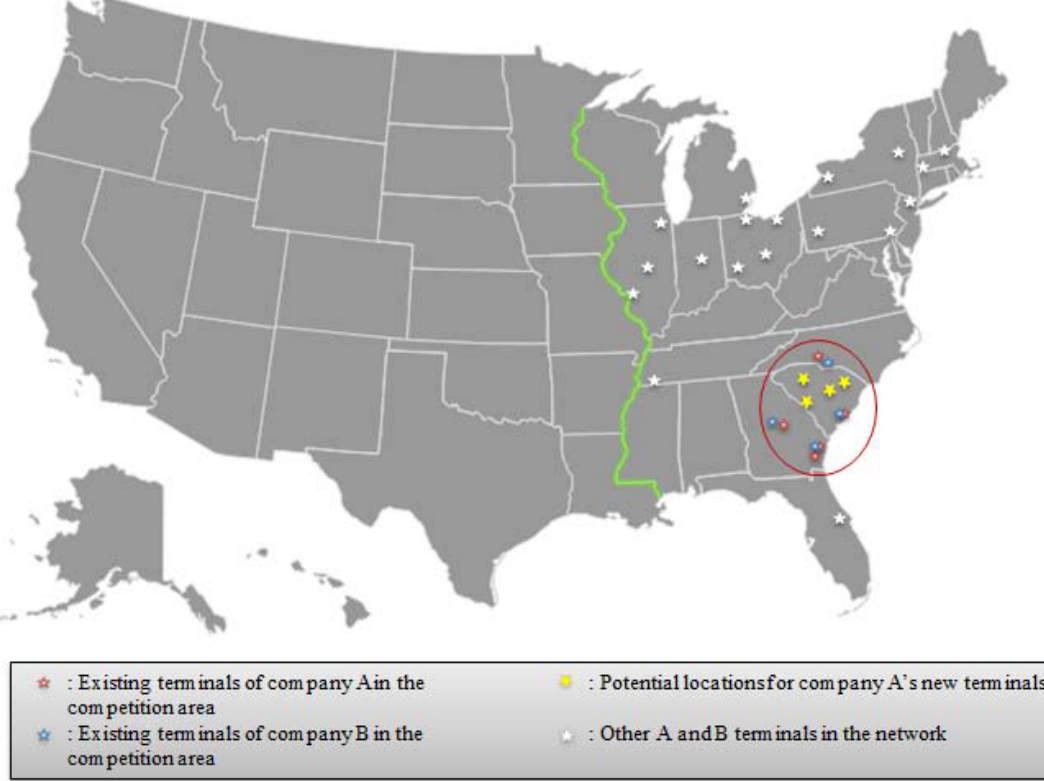
Fig. 2 Map of study area for case study